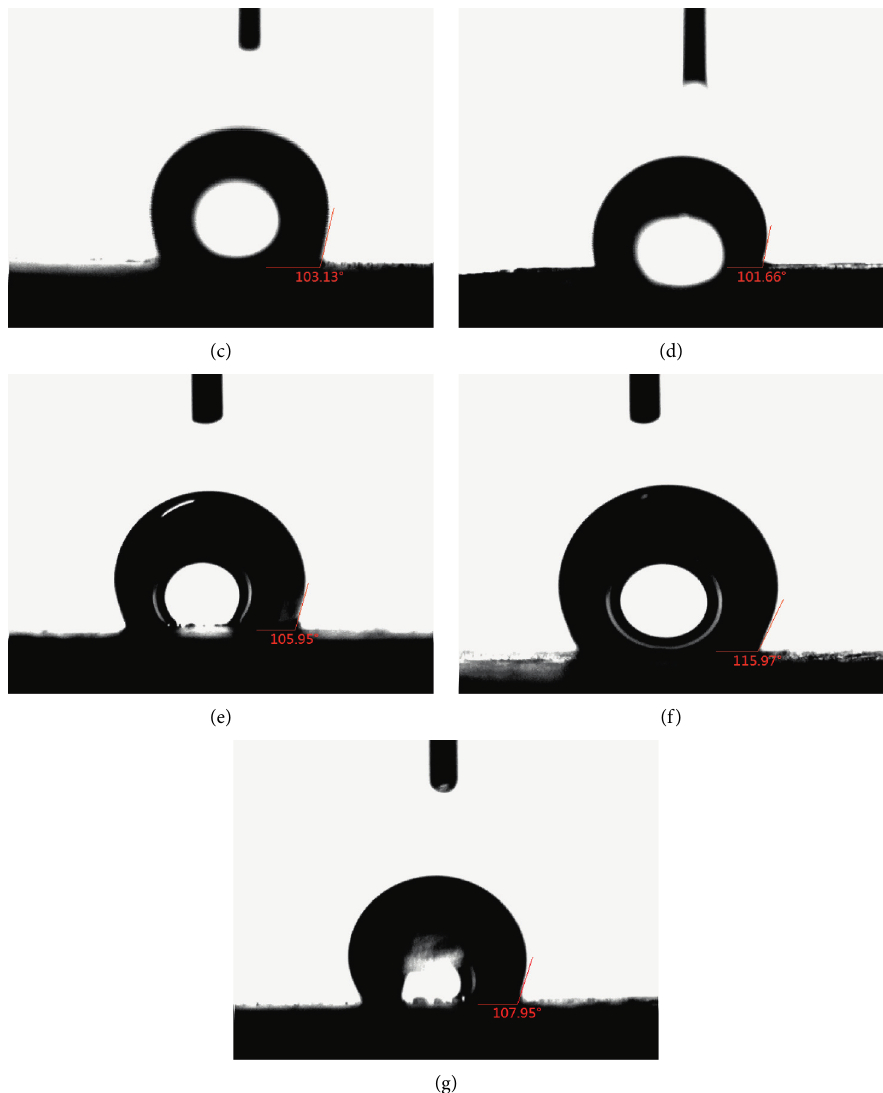
Figure 8: Contact angle of alkali-activated slag mortar. (a) C; (b) O100; (c) O200; (d) O300; (e) T100; (f) T200; (g)